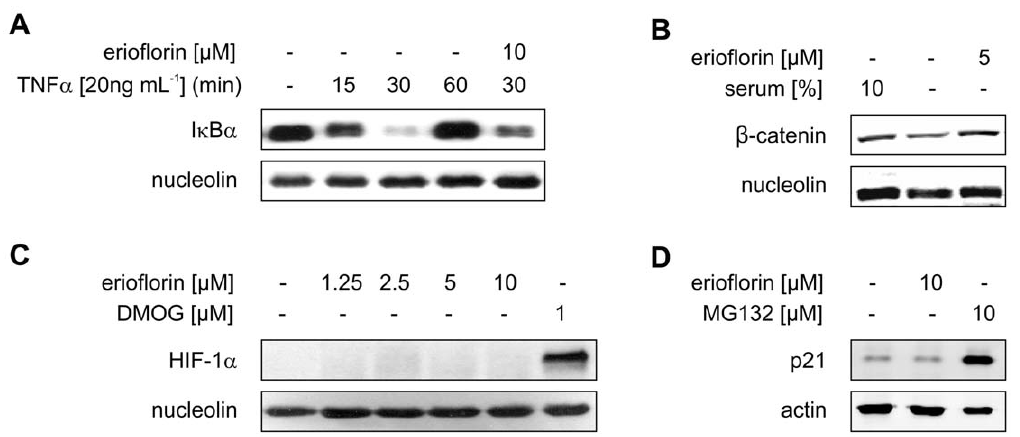
Figure 4. Erioflorin specifically inhibits E3-ligase b -TrCP1 activity. (A) HEK293 cells were treated with TNF a (20 ng mL –1 ) for the indicated times with or without erioflorin (10 m M). (B) HEK293 cells were maintained under full medium conditions (10% serum) or serum deprived for 24 h following treatment with erioflorin (5 m M) for 8 h. (C) HEK293 cells were treated for 8 h with erioflorin (1.25–10 m M) or the prolyl-hydroxylase inhibitor dimethyloxallylglycine (DMOG, 1 m M). (D) HeLa cells were serum deprived for 48 h prior to treatment with erioflorin (10 m M) or the proteasome inhibitor MG132 (10 m M) for 8 h. Whole cell extracts were subjected to western analysis and probed with the indicated antibodies. Blots are representative for at least three independent experiments.